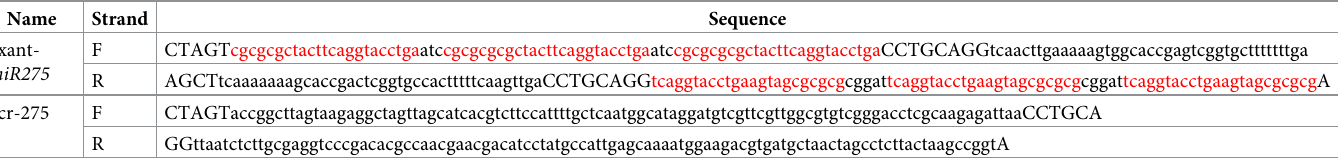
Table 1. Oligonucleotide sequences. Capitalized letters represent restriction endonuclease cut sites. Red =